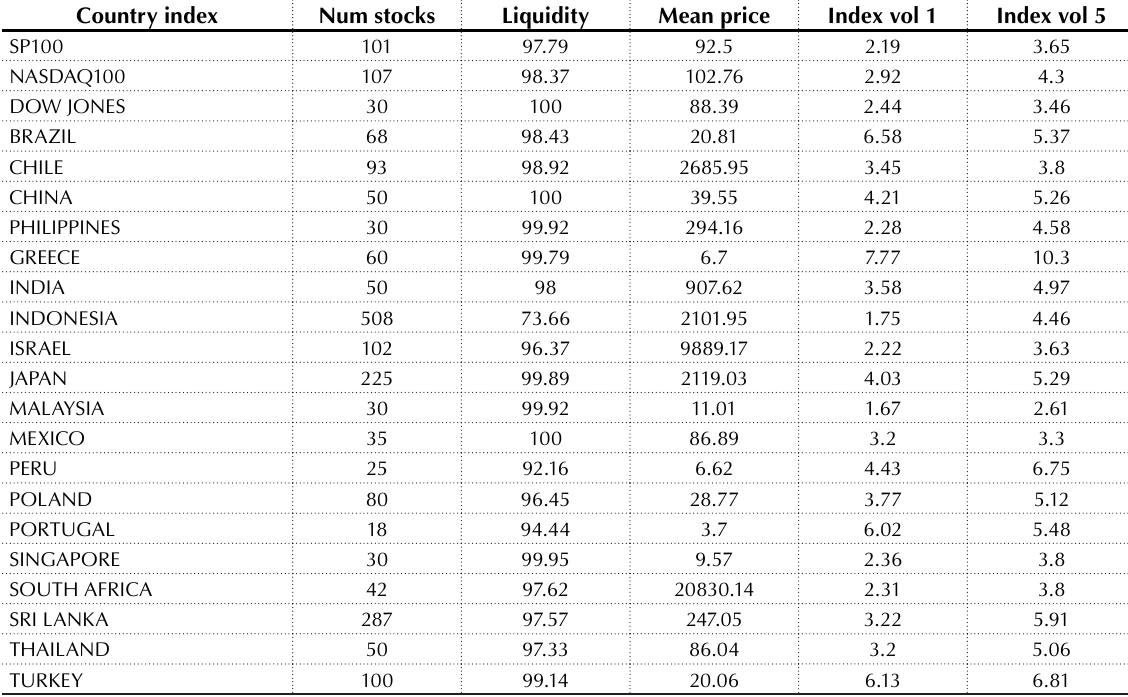
Table 1. Descriptive statistics of country